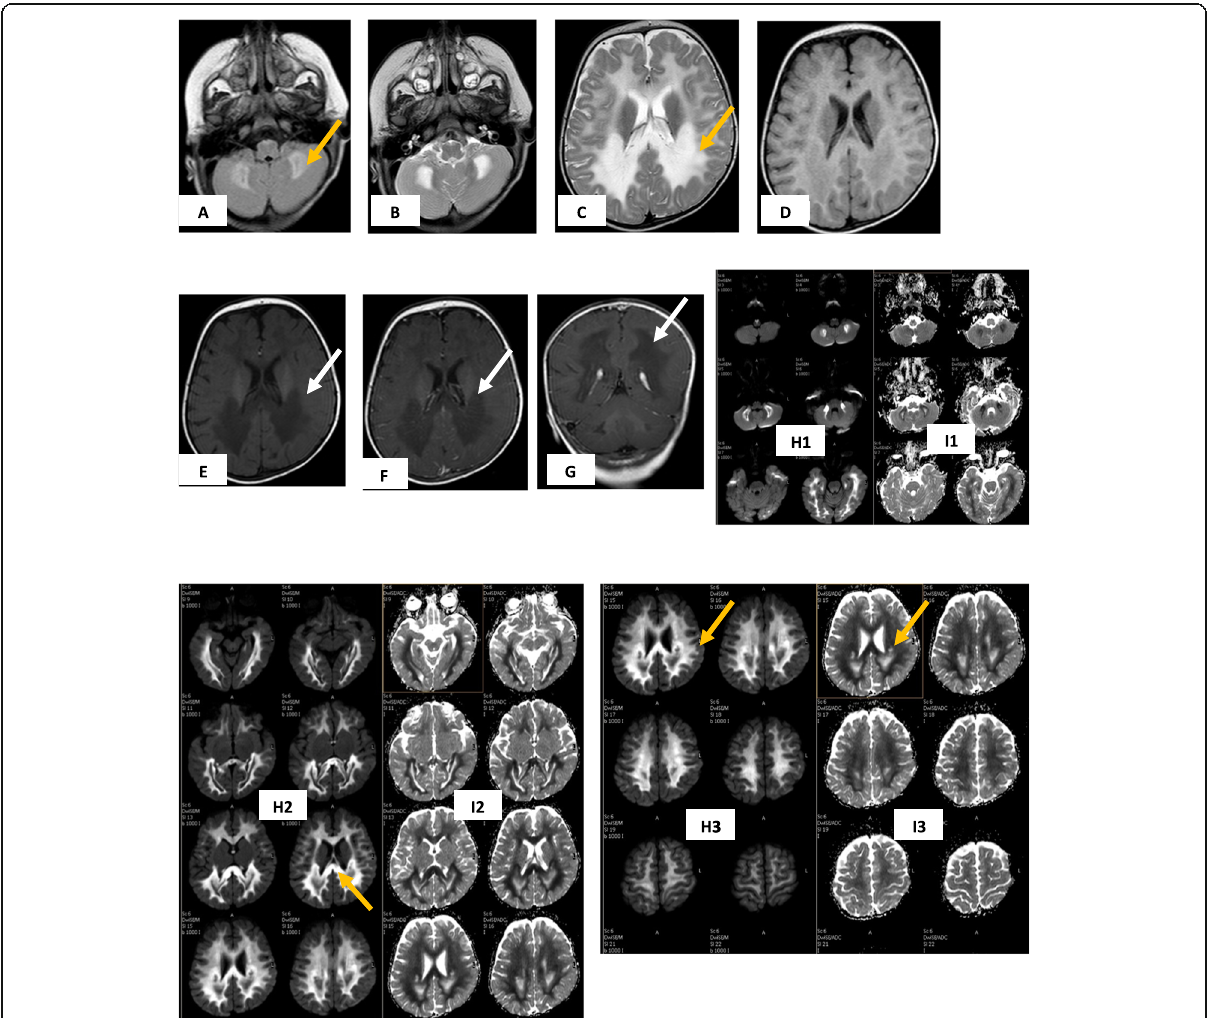
Fig. 4 15-yers-old girl with infantile form metachromatic leuckdystrophy . Different sequences MRI revealed bilateral symmetrical confluent foci of high T2 and FLAIR signal in the periventricular white matter (yellow arrows) with no enhancement at contrast series (white arrows in F,G ). The periventricular white matter and centrum semiovale showed tigroid patterns of demyelination (yellow arrow in “ C ” T2WI). Extension of the abnormality into the corpus callosum (yellow arrow in H2 ) and the internal capsule as well as corticospinal tracts also were